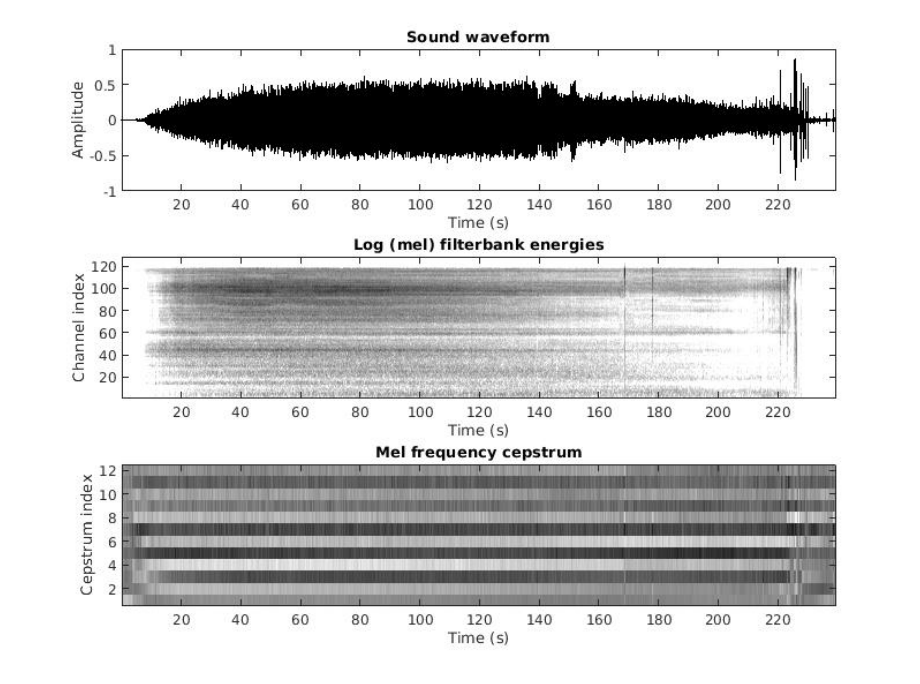
Figure 6. The sound waveforms, the logarithm of the filterbank energies, and the mel-frequency cepstrum graphic representation for the kettle sound.